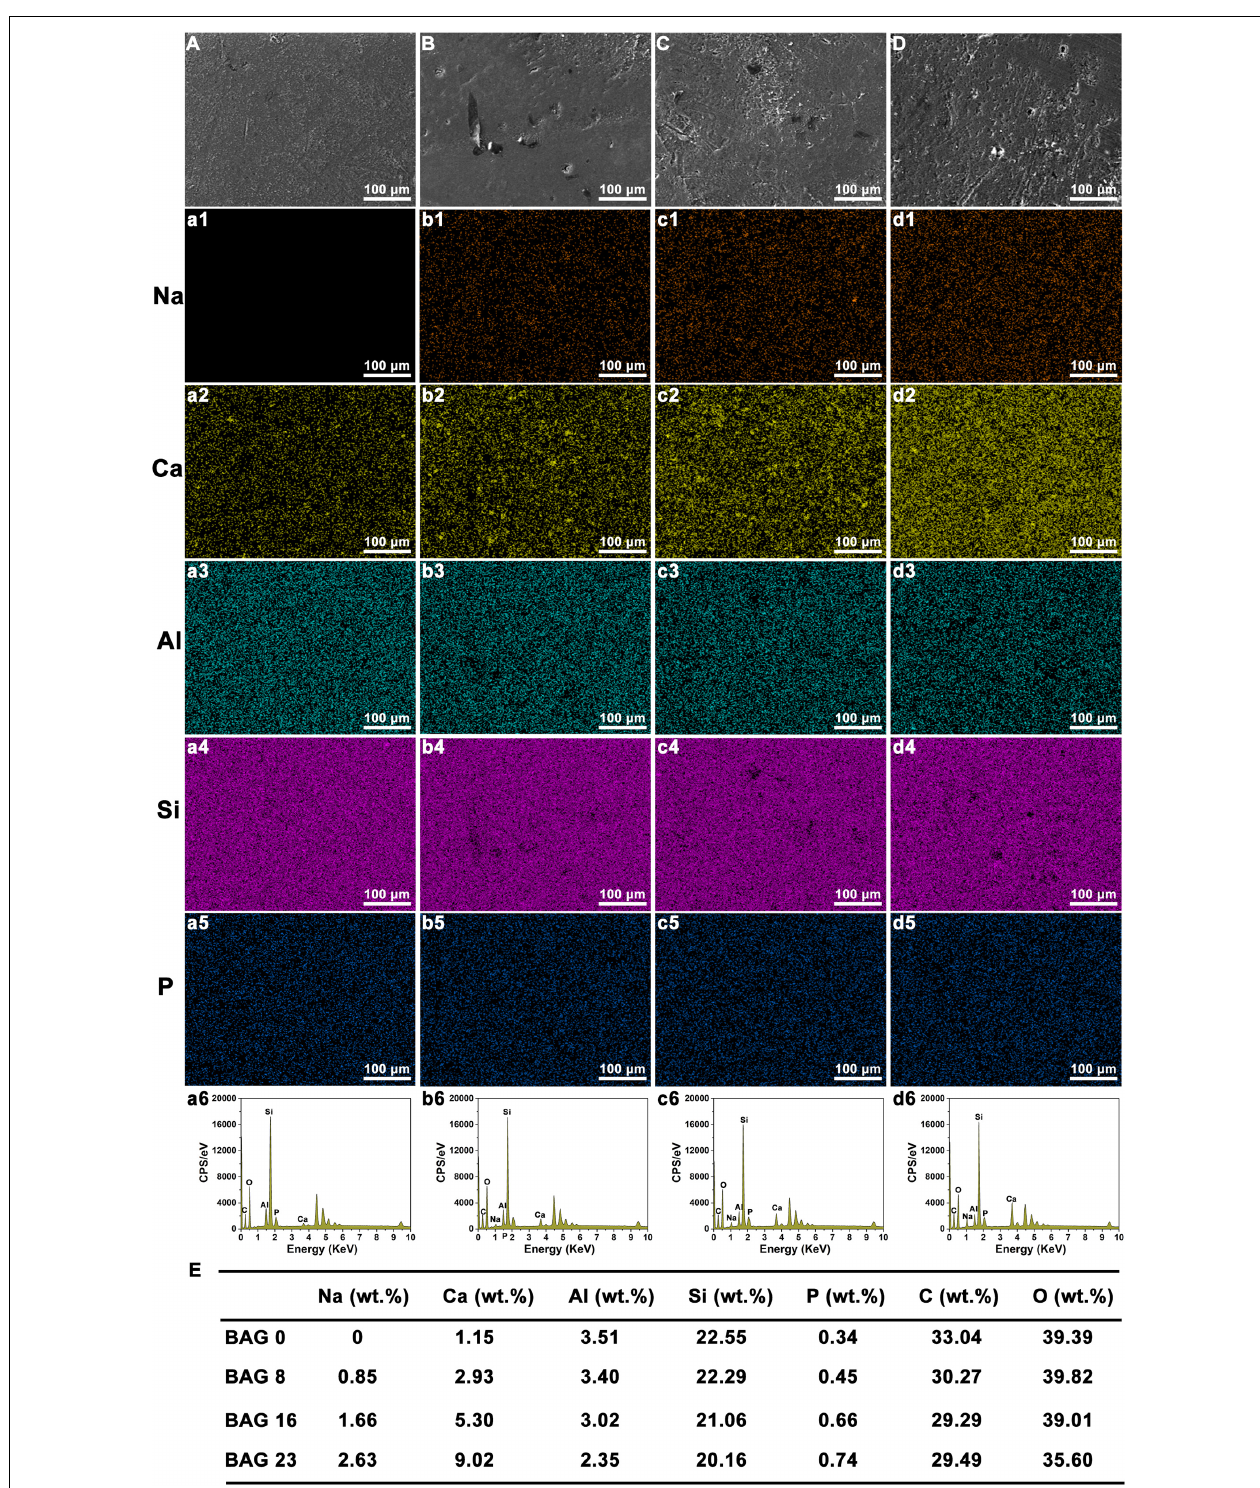
FIGURE 1 | Scanning electron microscopy (SEM) with energy-dispersive X-ray spectroscopy (EDS) mapping analysis of bioactive glass (BAG)-modified composite resins. (A–D) SEM images; EDS mapping analysis of Na element (a1–d1) ; Ca element (a2–d2) ; Al element (a3–d3) ; Si element (a4–d4) ; P element (a5–d5) . (A, a1–a6) BAG0 group; (B, b1–b6) BAG8 group; (C, c1–c6) BAG16 group; (D, d1–d6) BAG23 group; (E) Quantitative analysis of various elements in BAG-modified composite resins. BAG0 indicates composite resin without BAG; BAG8 indicates composite resin with 8 wt% BAG; BAG16 indicates composite resin with 16 wt% BAG; BAG23 indicates composite resin with 23 wt%